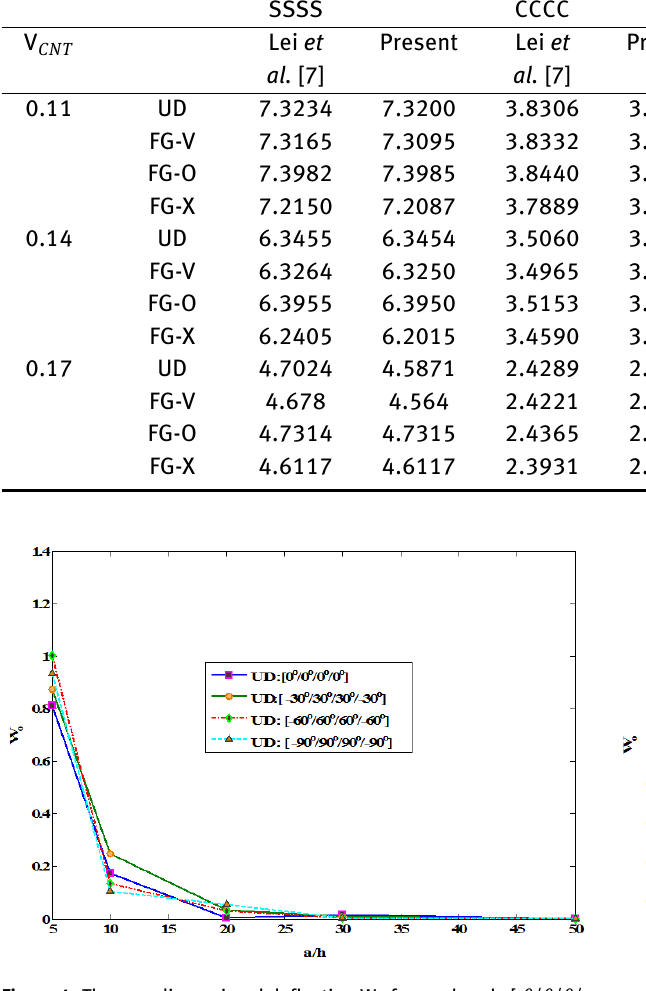
Figure 5: The non-dimensional deflection W o for angle–ply [- θ / θ / θ /- θ ] FG-O plate with different lamination scheme laminationscheme[0/0/0/0]plateismorestiffnessascom- pare to other lamination